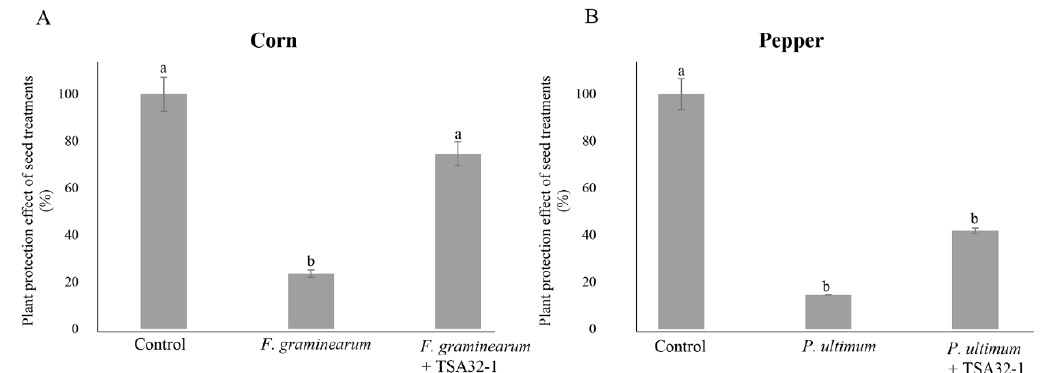
Figure 4. The seed germination rate of seed treatments. ( A ) Treatments of the prototype TSA32-1 for head blight disease in corn caused by Fusarium graminearum KACC41044. ( B ) Treatments of the prototype TSA32-1 for damping-off disease in pepper caused by Pythium ultimum KACC40705. Data are expressed as the means ± SD. Significant differences are marked with letters ( p < 0.05). Control, untreated check; fungal pathogen, infected pathogen; fungal pathogen + TSA32-1, pathogen inoculation after seed dipping.